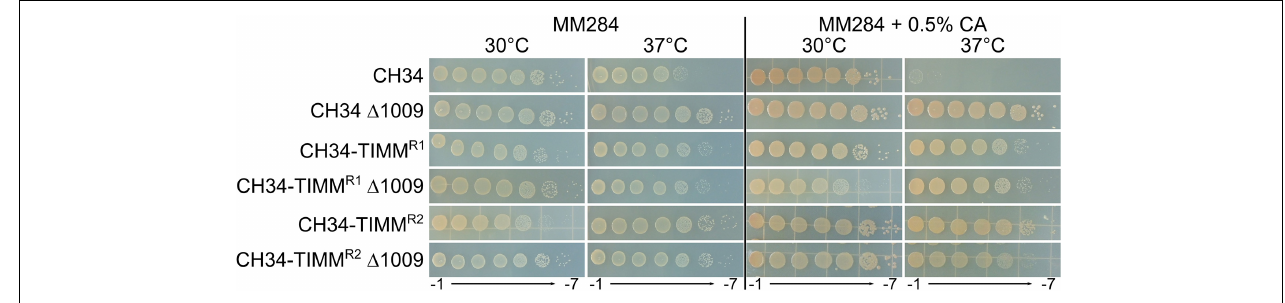
FIGURE 3 | Tenfold serial dilution of stationary-phase cultures of CH34, CH34-TIMM R 1 and CH34-TIMM R 2 , and their Rmet_1009 insertional knockout mutants spotted on MM284 agar plates with and without 0.5% (w/v) CA and incubated for 2 days at 30 and 37 ◦ C.